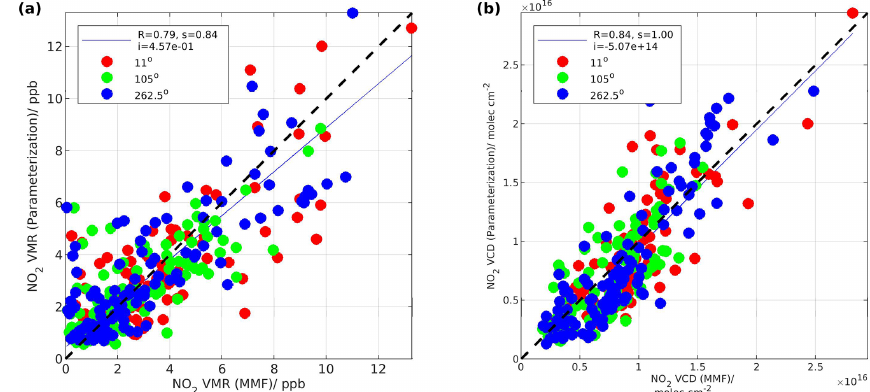
Figure 9. Visible range: comparison between MMF and (a) parameterized NO 2 near-surface VMR as well as (b) parameterized NO 2 VCD at three different azimuthal directions, as indicated in the color bar (11, 105, and 262.5 ◦ azimuthal directions). The elevation scans in these azimuthal directions were performed once per day from 3 July 2019.